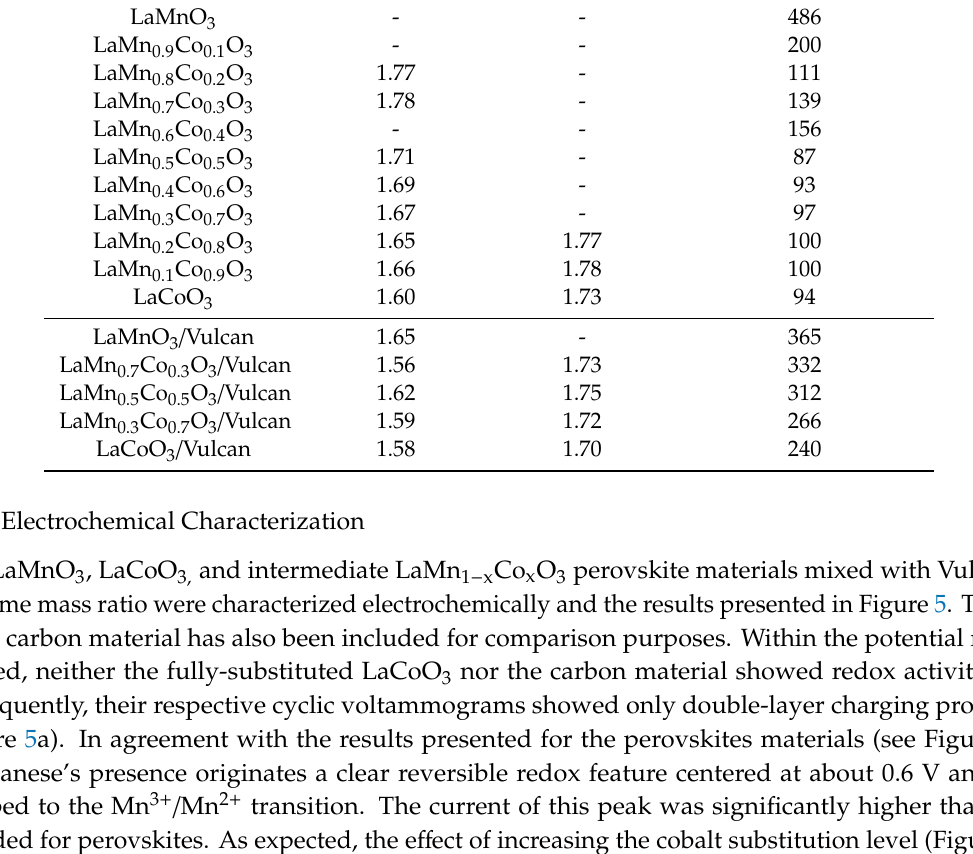
Electrochemical parameters obtained for perovskite materials and mixed materials (perovskite:Vulcan with 1:1 mass ratio) tested in the oxygen evolution reaction (OER). Potential / V Potential / V Sample Tafel Slope / mV dec − (at 1 mA cm − 2 ) (at 5 mA cm − 2 )